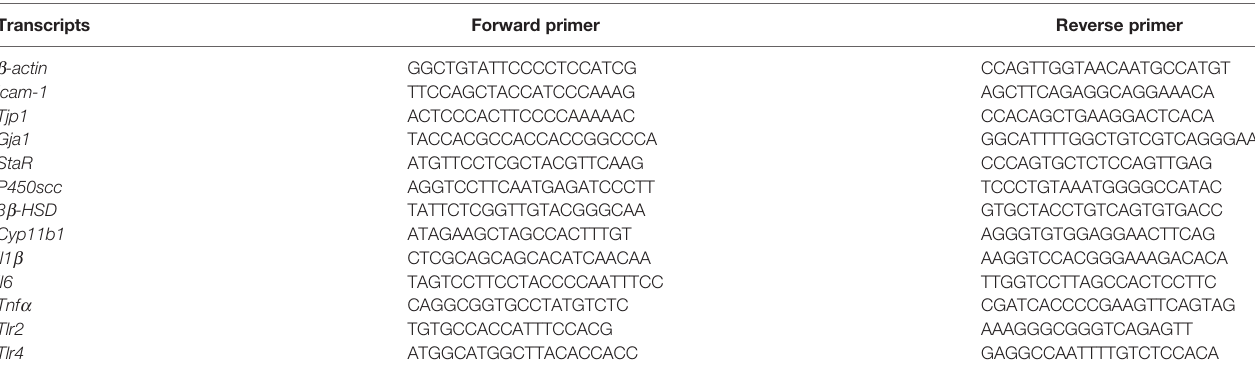
TABLE 1 | Primers sequences used in the real-time quantitative PCR reaction.